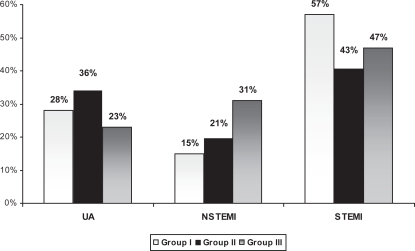
Comparison of clinical presentation with ACS in different age groups (P < 0.01).